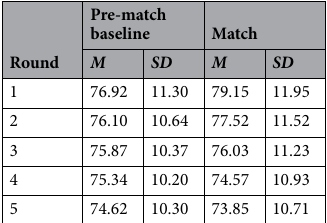
Table 1. Means and standard deviations for HR levels for pre-match baselines and matches.